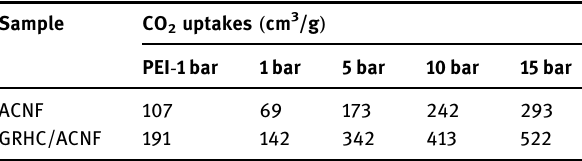
Table 8: CO 2 uptakes at di ff erent pressures at